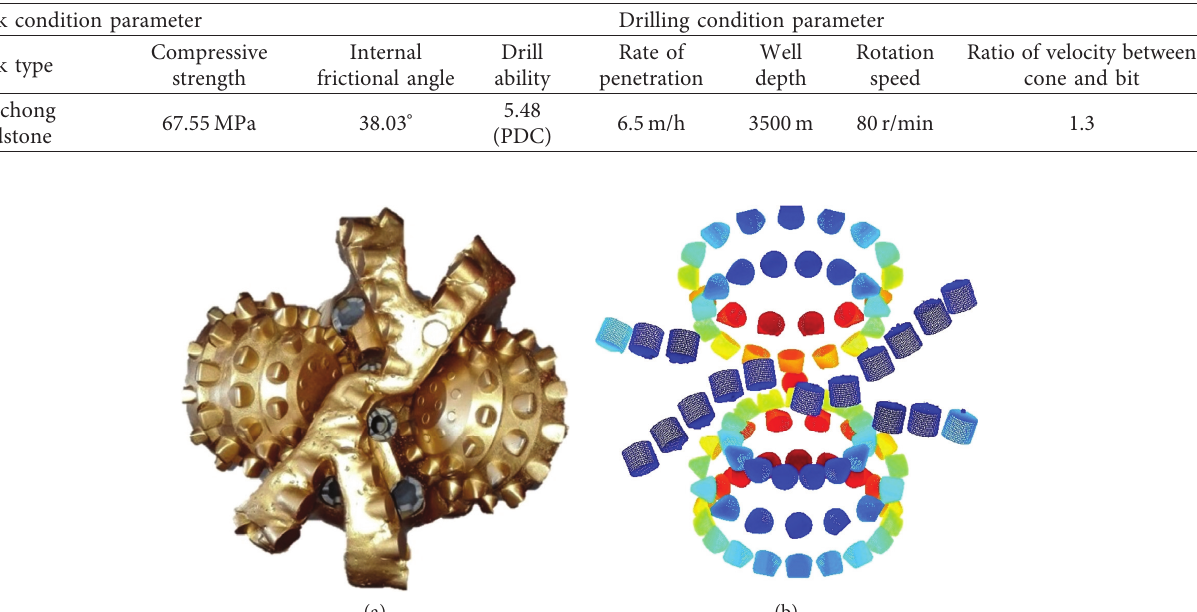
Table 1: Working load calculation conditions of 8-1/2 inch, 2+4 hybrid drill bit.